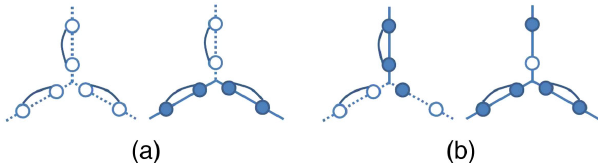
FIG. 9. (a) Low-energy and (b) high-energy configurations at each vertex. Dotted lines represent links without strings, while solid lines represent links with strings. Empty circles represent spinless vertex particles, while solid circles represent spin- 1 = 2 ’ s. Two connected circles form a singlet.